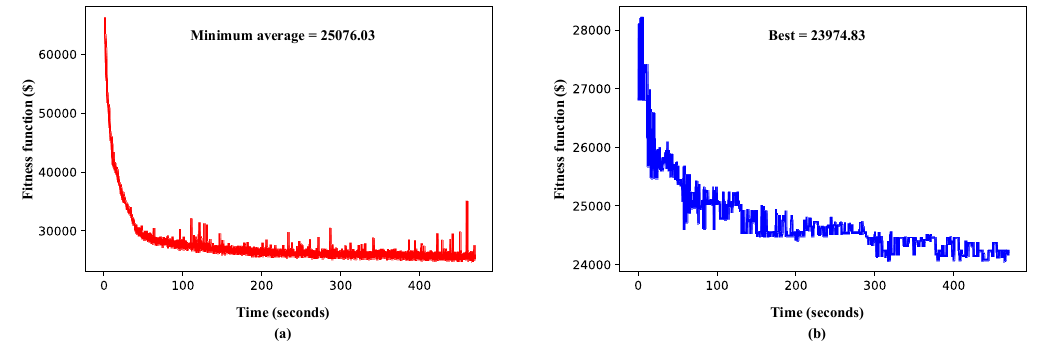
Fig. 7. (a) The change of the average fitness function of the GA with time for the fast demand fulfillment, (b) The change of the best fitness function of the GA with time for the fast demand